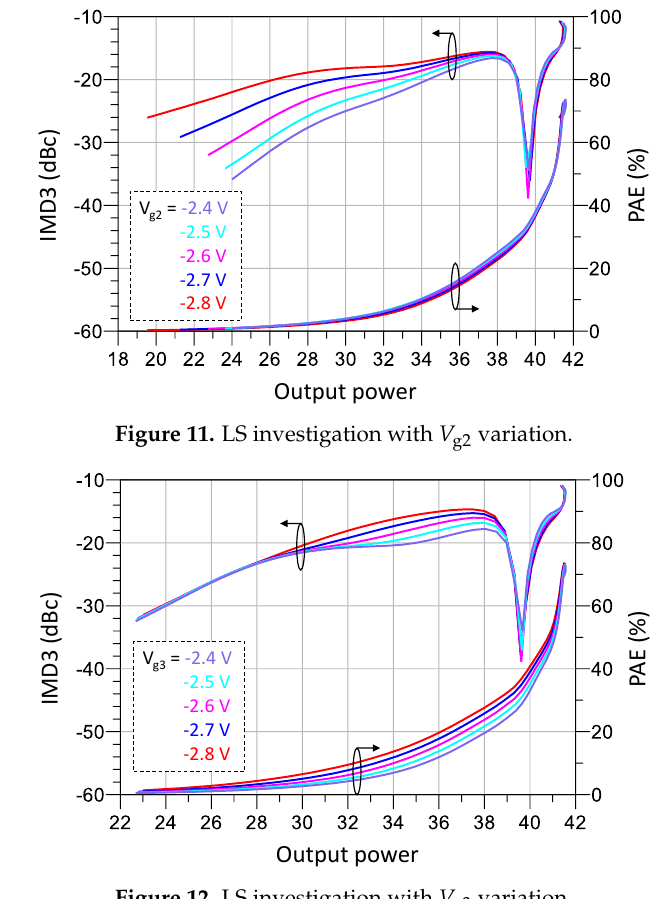
Figure 12. LS investigation with V g3